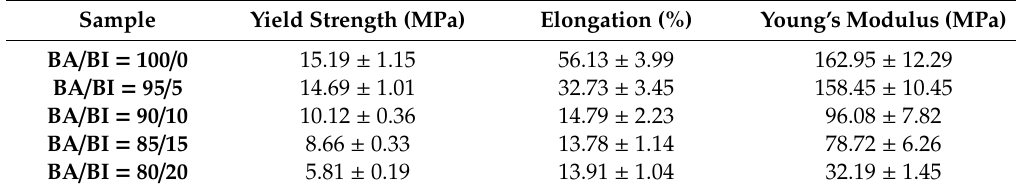
Figure 7. The stress–strain curves of PBABI copolyesters. Table 3. Mechanical properties of PBABI copolyesters.